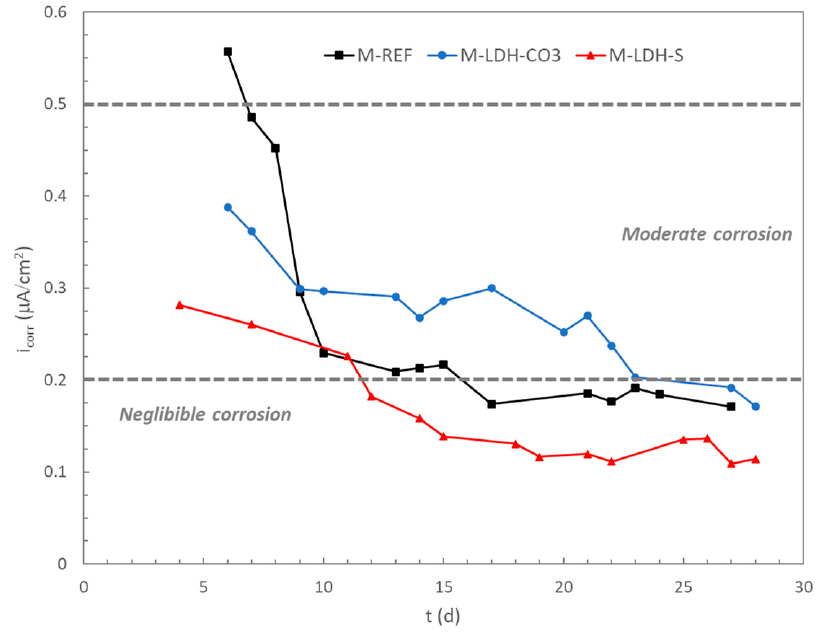
Figure 6. Evolution of the corrosion current density for the three studied reinforced mortars during the passivation stage.